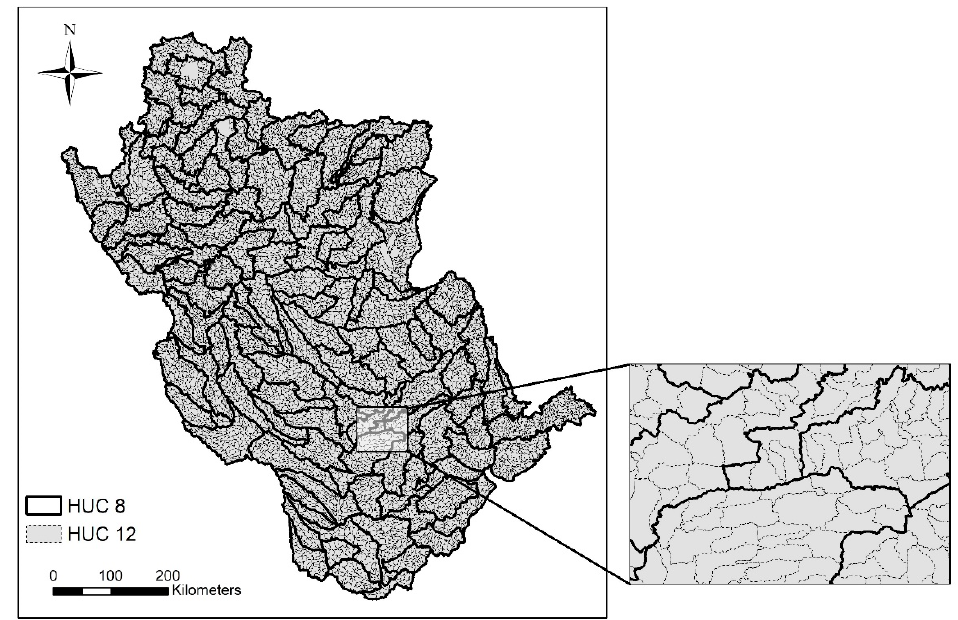
Figure 3. Eight-digit and 12-digit subbasins within the study area.